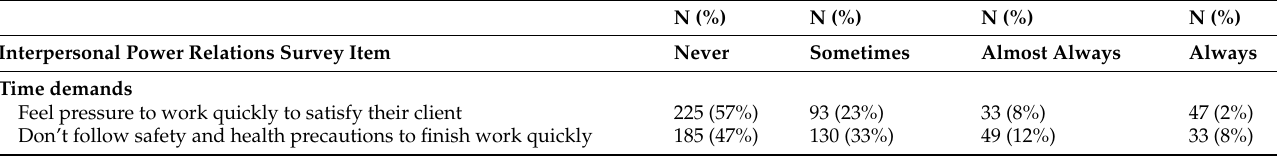
Table 2. Employment Quality Indicators for Interpersonal Power Relations with Client: Safe and Just Cleaners